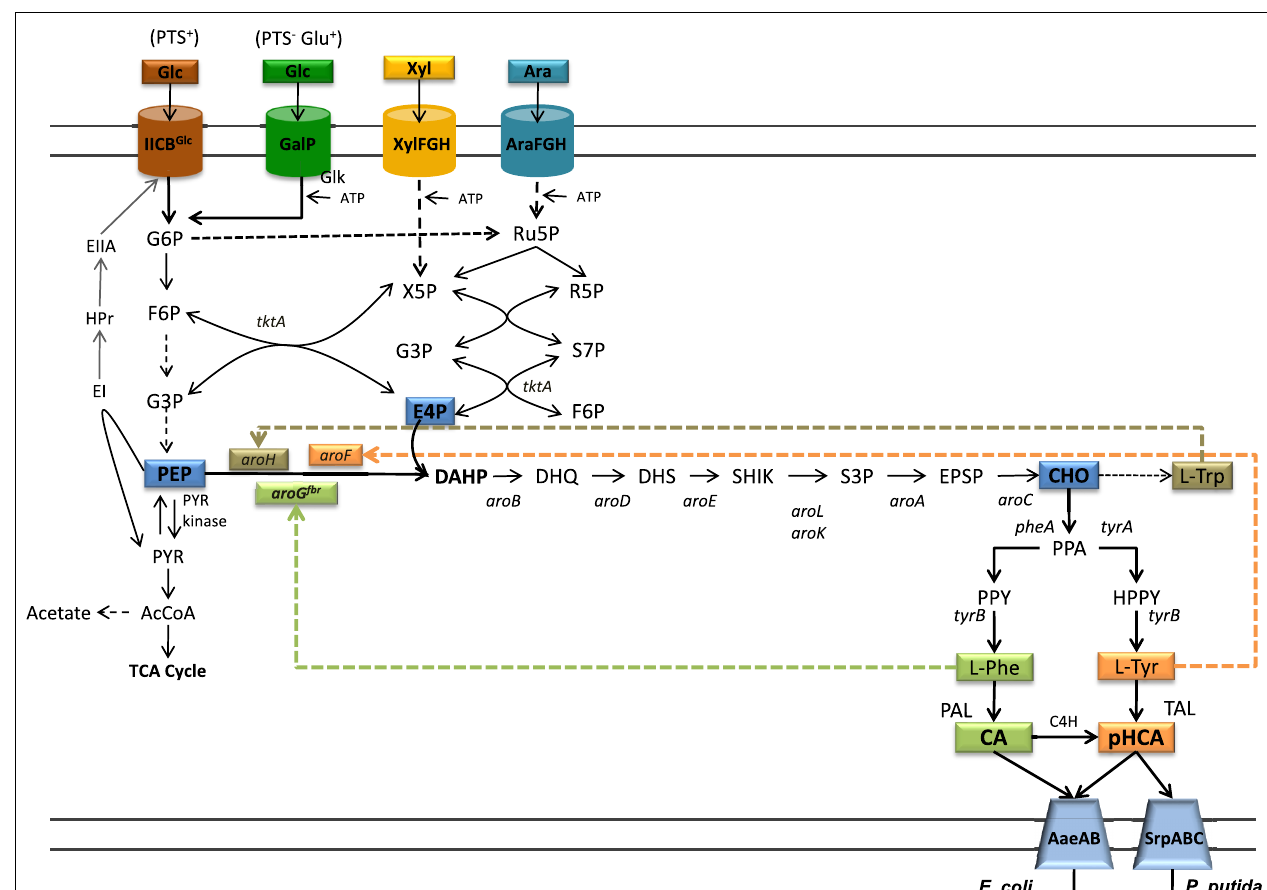
transketolase; tyrB , tyrosine aminotransferase gene; PAL, phenylalanine ammonia lyase; TAL, tyrosine ammonia lyase; C4H, cinnamate 4-hydroxylase; AaeXAB, efflux pump from E. coli ; SprABC, efflux pump from P. putida ; G6P, glucose-6-phosphate; F6P, fructose-6-phosphate; G3P, glyceraldehyde-3- phosphate; PEP, phosphoenolpyruvate; R5P, ribose-5-phosphate; Ru5P, ribulose-5-phosphate; S7P, sedoheptulose-7-phosphate; X5P, xylulose-5- phosphate; PYR, pyruvate; AcCoA, acetyl-CoA; TCA, tricarboxylic